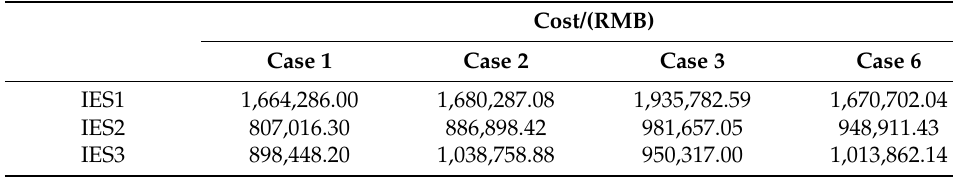
Table 12. Comparison of the results of Cases 1–3 and 6.